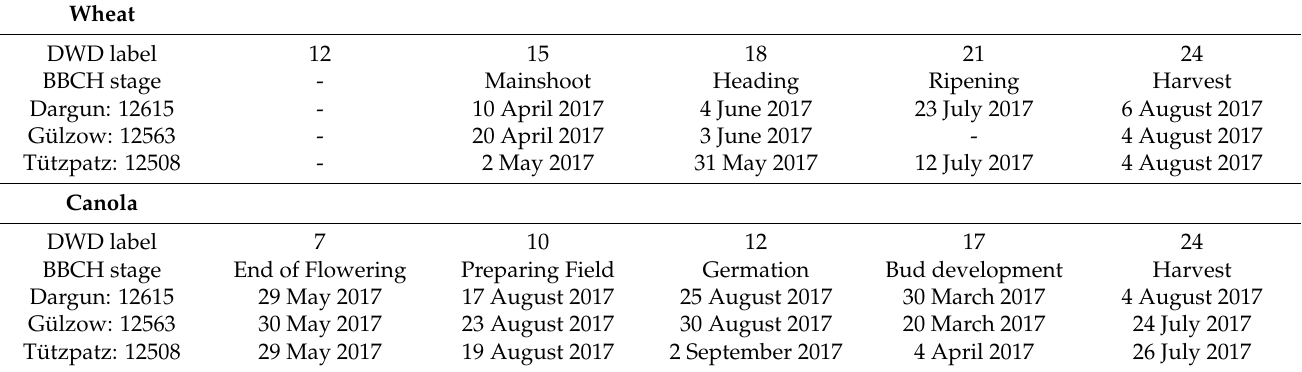
Table 1. Information on phenological events in 2017 provided by the DWD per station (with ID).